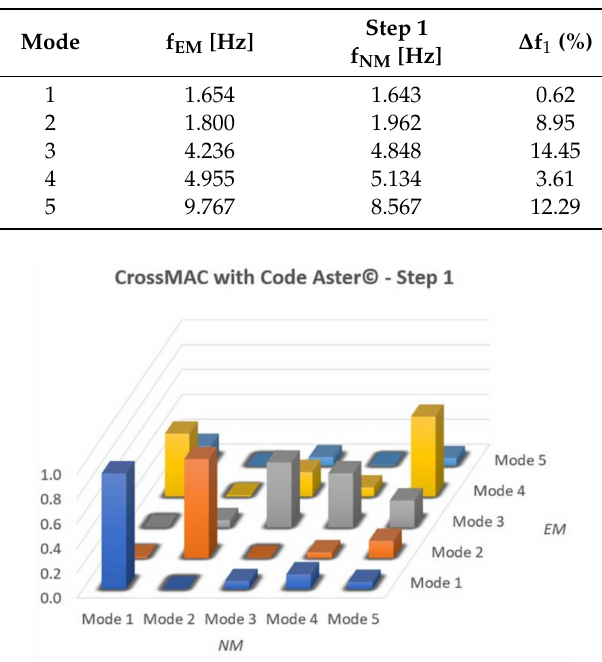
Figure 12. CrossMAC between EM and NM at step 1 with Code Aster © .